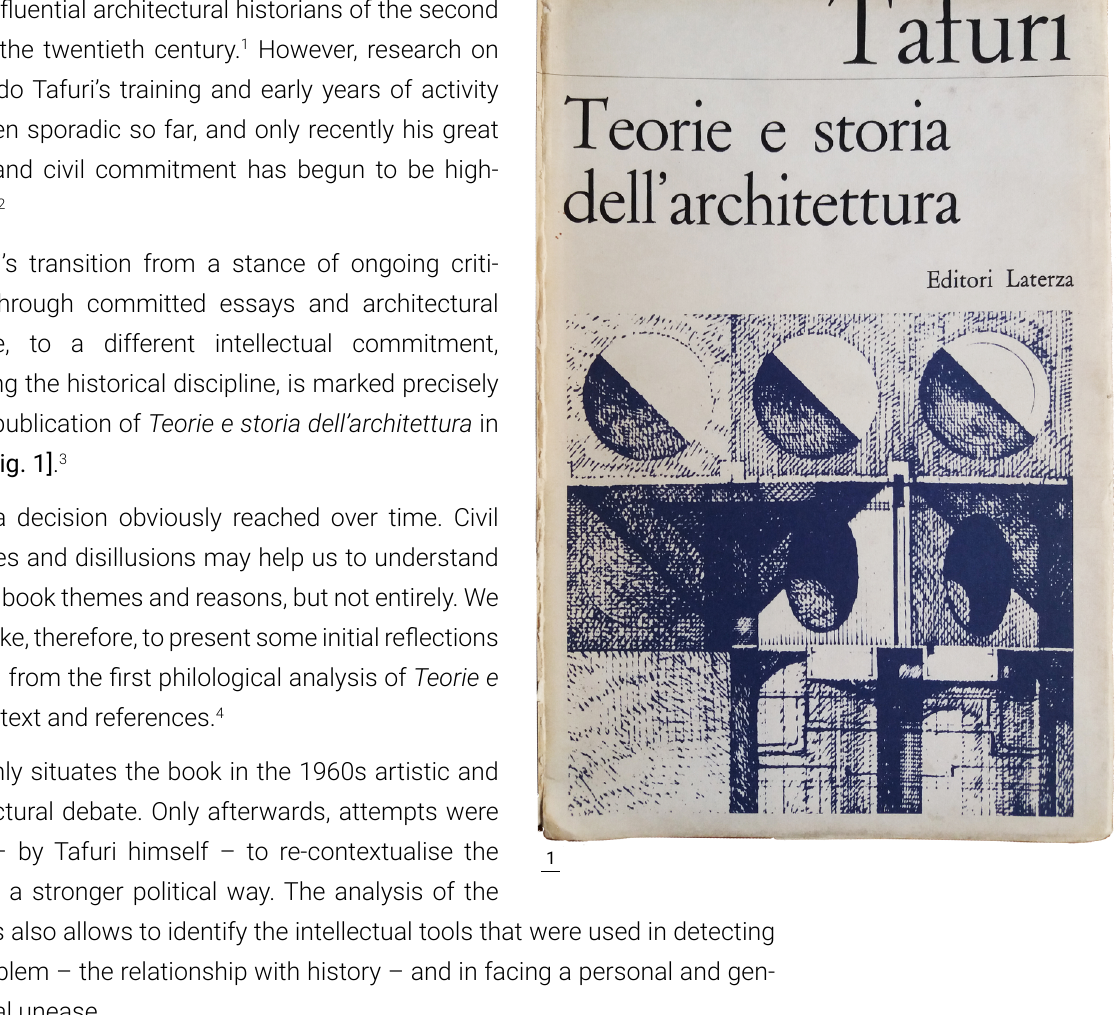
Fig. 1 Cover of Manfredo Tafuri, Teorie e storia dell’architettura , 1st ed. (Bari: Editori Laterza,